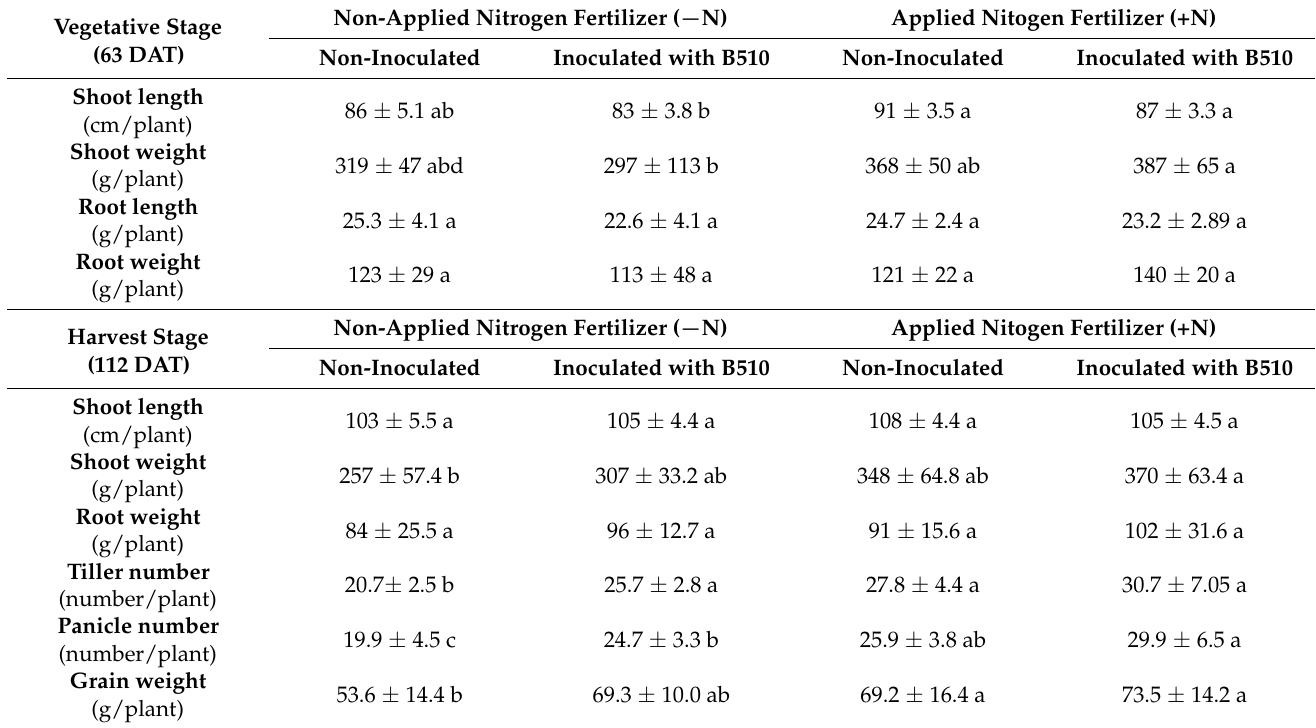
Table 1. Effect of Azospirillum sp. B510 inoculation on the plant